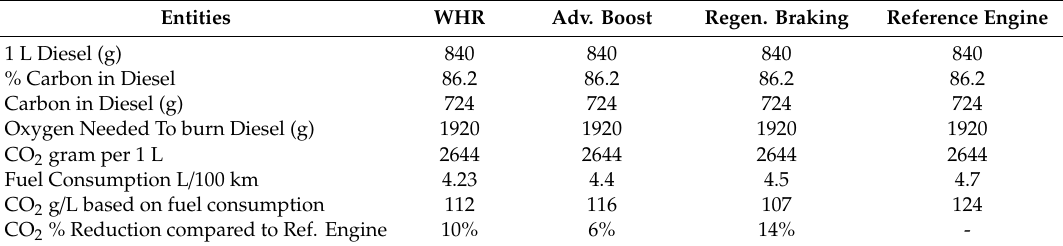
Table 2. Calculation of CO 2 Reduction through Fuel